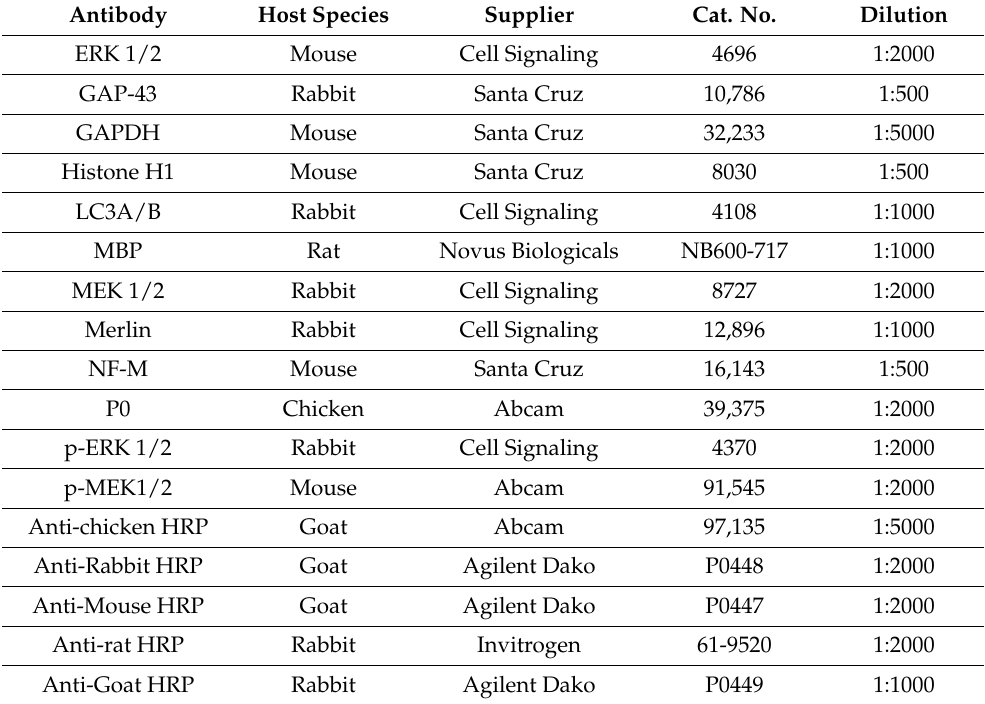
Table 1. List of